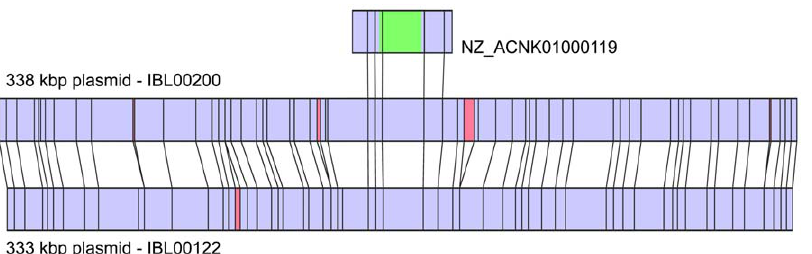
Figure 2. Optical maps of the 338 kbp and 333 kbp plasmids from IBL 200 and IBL 122, respectively, as cleaved by XbaI. Highly similar areas are shaded in blue, while dissimilar regions are red. The smaller map above the plasmids represents the predicted XbaI cleavage of the 42 kbp genomic sequence from IBL 200 bearing the tca operon (location shaded in green).